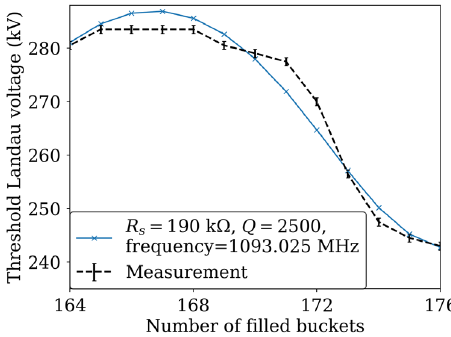
FIG. 9. Threshold Landau-cavity voltage for different fill patterns in the MAX IV 3 GeVas calculated for HOM parameters chosen to reproduce the measured